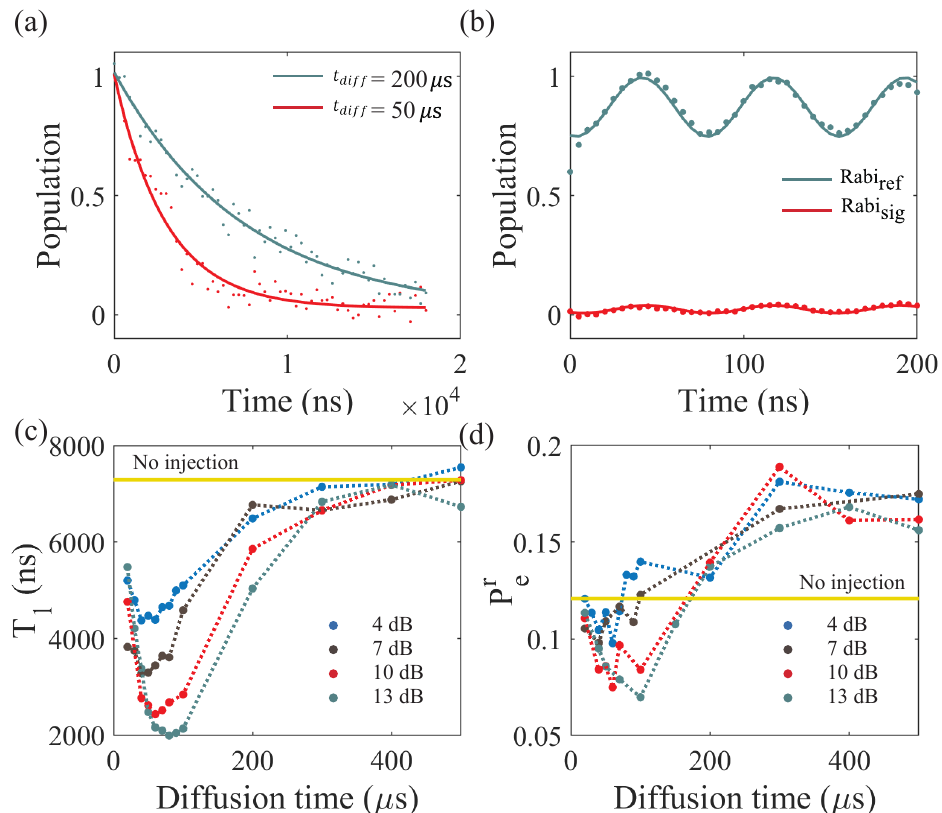
Figure 2. Experimental impacts of injected quasiparticles. ( a ) State evolution of the energy relaxation time T 1 measured by injecting the power of 7 dB. The green data were measured with a diffusion time of 50 µ s, while the red data were measured when t dif f = 200 µ s. ( b ) Rabi oscillations observed with 7 dB of injection power and 50 µ s of diffusion time. The green line represents the reference Rabi oscillation, while the red line represents the signal Rabi oscillation. From the amplitudes of the Rabi oscillation, we can calculate the residual excited-state population [11]. ( c ) The energy relaxation time T 1 and ( d ) residual excited-state population P r e were measured as a function of t dif f . The four curves in each figure represent, respectively, the responses of the qubit induced by quasiparticle injection with injection powers of 4, 7, 10, and 13 dB. The yellow line represents the data without the quasiparticle injection. The data were measured with an injection duration time of 3 µ